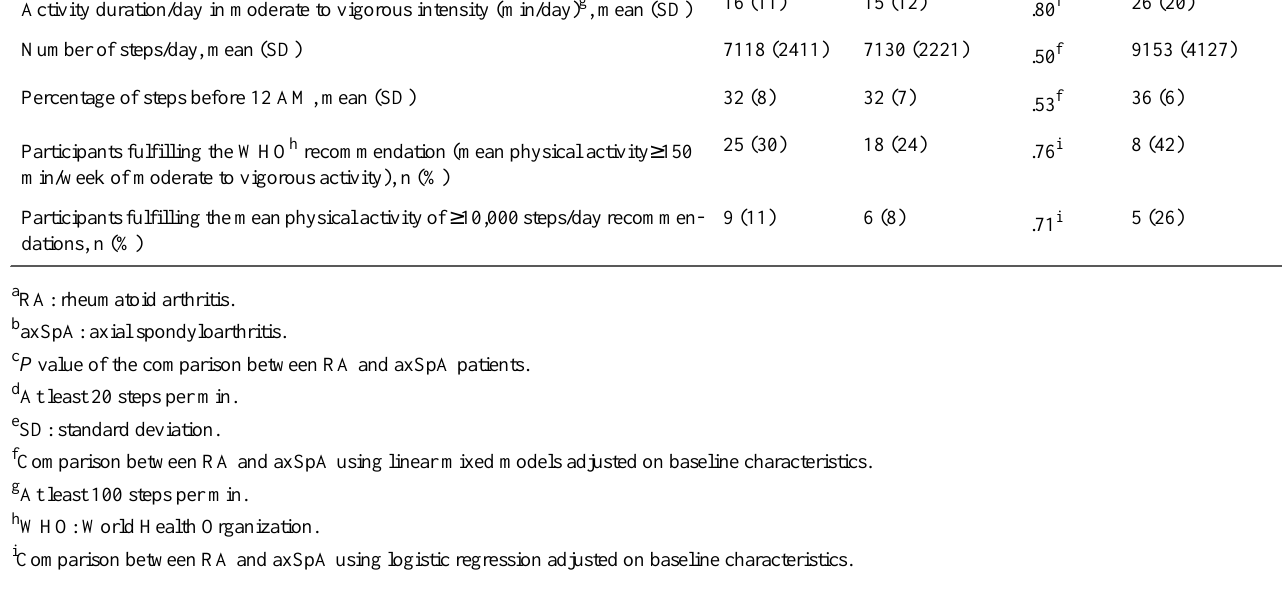
Figure 2. Distribution of physical activity patterns in 83 rheumatoid arthritis and 74 axial spondyloarthritis patients and in 19 controls: (A) mean duration of moderate to vigorous activity (min per day) and (B) mean number of daily steps (steps per day). RA: rheumatoid arthritis; axSpA: axial